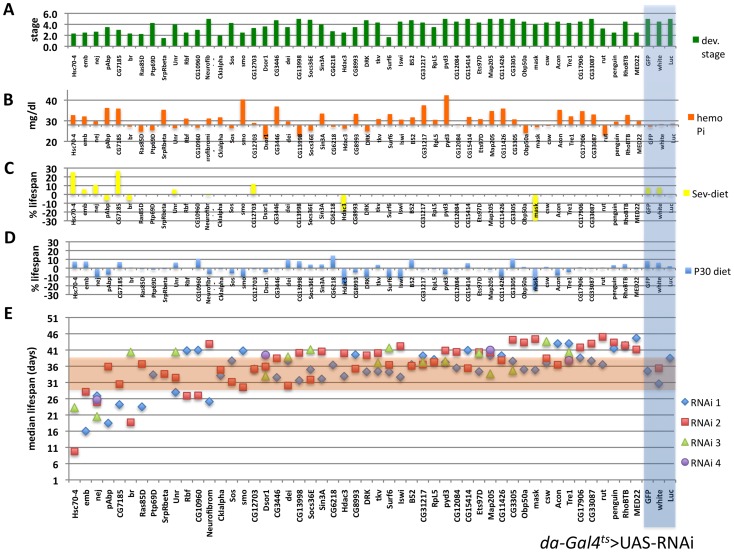

In vivo secondary screen using the da-Gal4
ts as driver identifies genetic modifiers of Drosophila larval development, and adult hemolymph phosphate and lifespan.
A: Developmental stage on standard medium, B: hemolymph phosphate concentration of young adult females cultured at 29°C for five days, and % change of life span on standard medium supplemented with 1% sevelamer (C), or 30 mM sodium phosphate (D) when compared to standard medium alone (E) (see also Table S1).